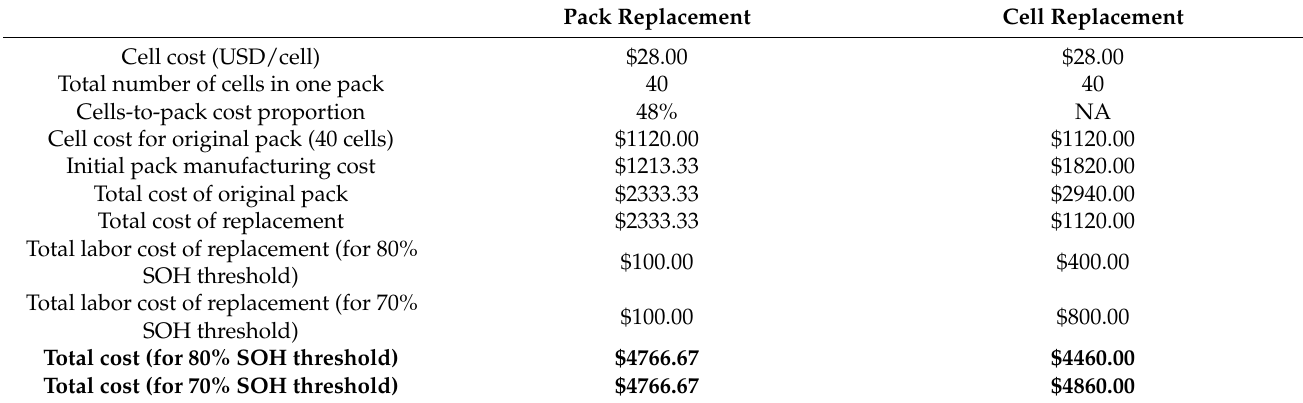
Table 4. Cost analysis and comparison between cases of pack replacement and cell replacement. Pack